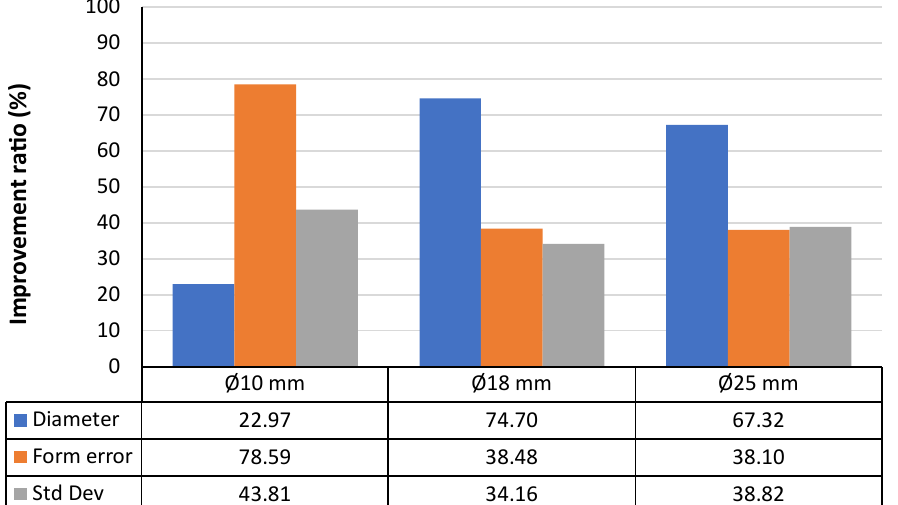
Figure 13. Improvement ratio in the noncontact measurement for the three parameters studied and the three diameters considered after the chemical bath process.